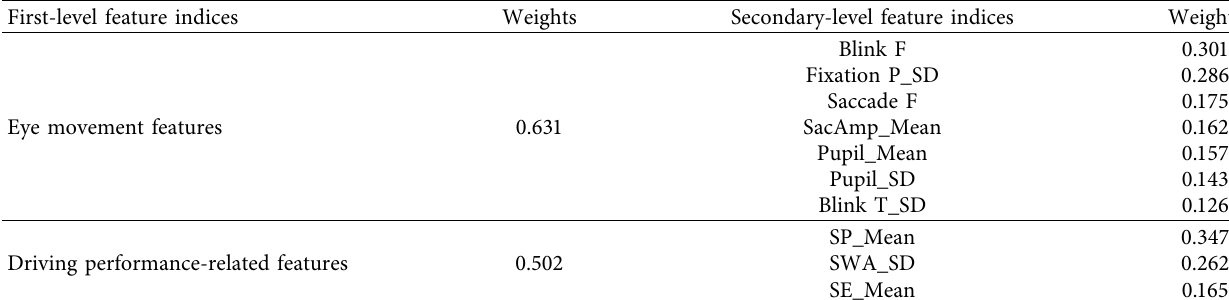
Table 4: Feature-level division.